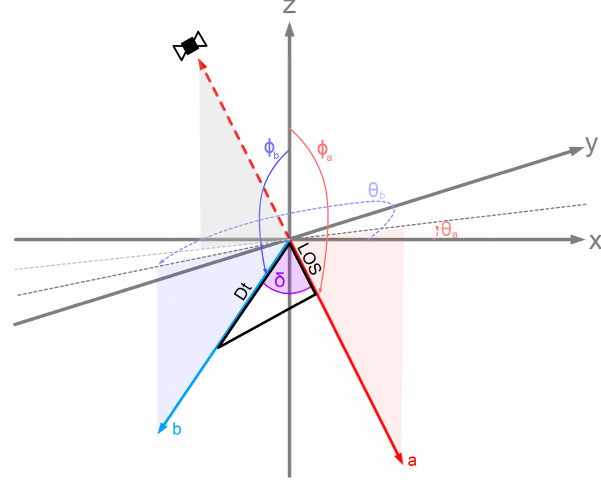
Figure 4. Vector geometries used to project measured line-of-sight displacements (LOS) onto the fall line ( b ). For a and b , θ describes the azimuth from x (east), and φ describes the angle from positive up. The angle δ between a and b controls how much of the true deformation is visible in the satellites